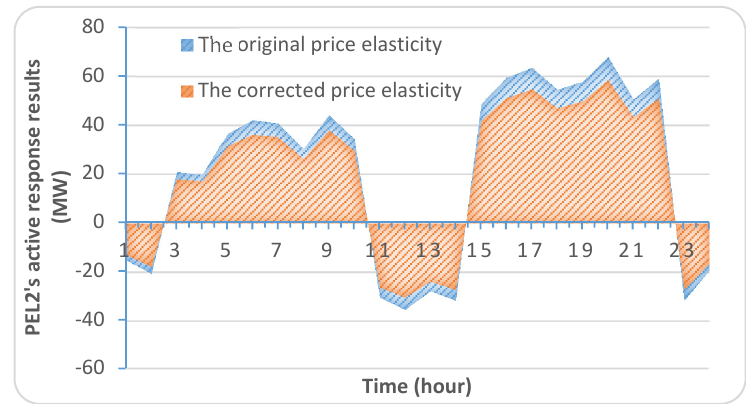
Figure 8. Demand response amount of PEL 2 with changing α